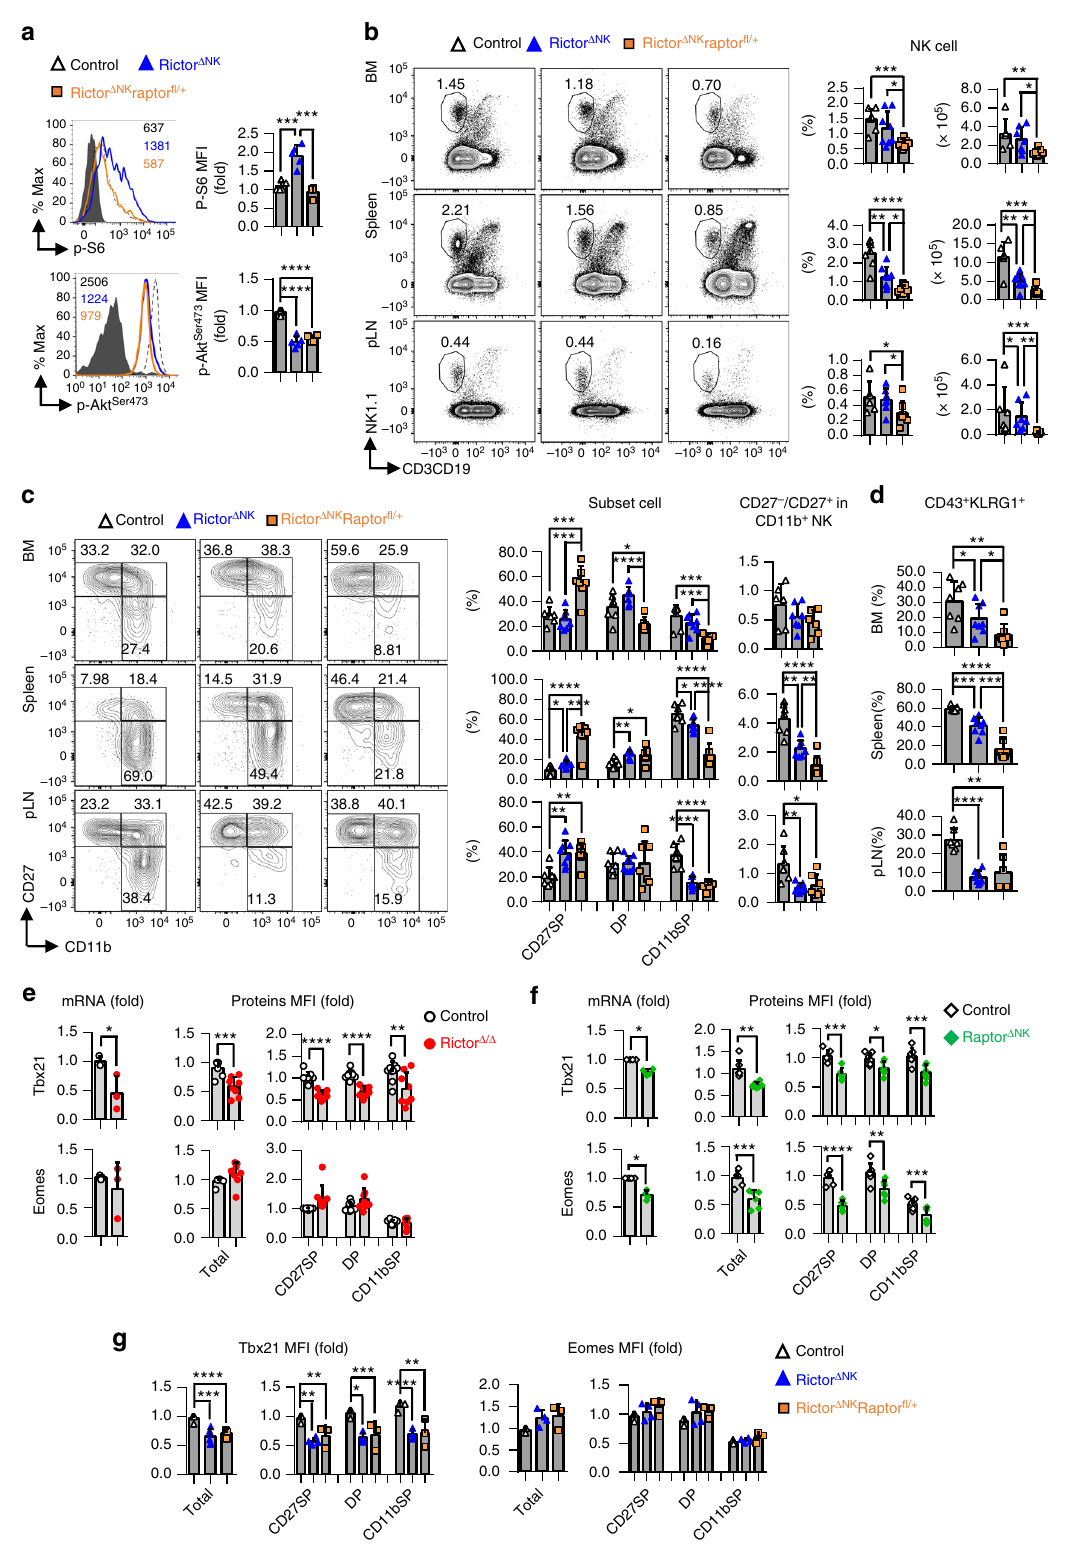
reversed by STAT5-IN treatment ( Fig. 7i). Furthermore, a speci fi c inhibitor of SLC7A5, 2-amino-2-norbornanecarboxylic acid (BCH) 37 , could also inhibit the enhanced mTORC1 activity in Rictor-de fi cient NK cells (Fig. 7j). Overall, our results indicated that the increased mTORC1 activity in Rictor-de fi cient NK cells was mainly attributed to the enhanced STAT5 – SLC7A5